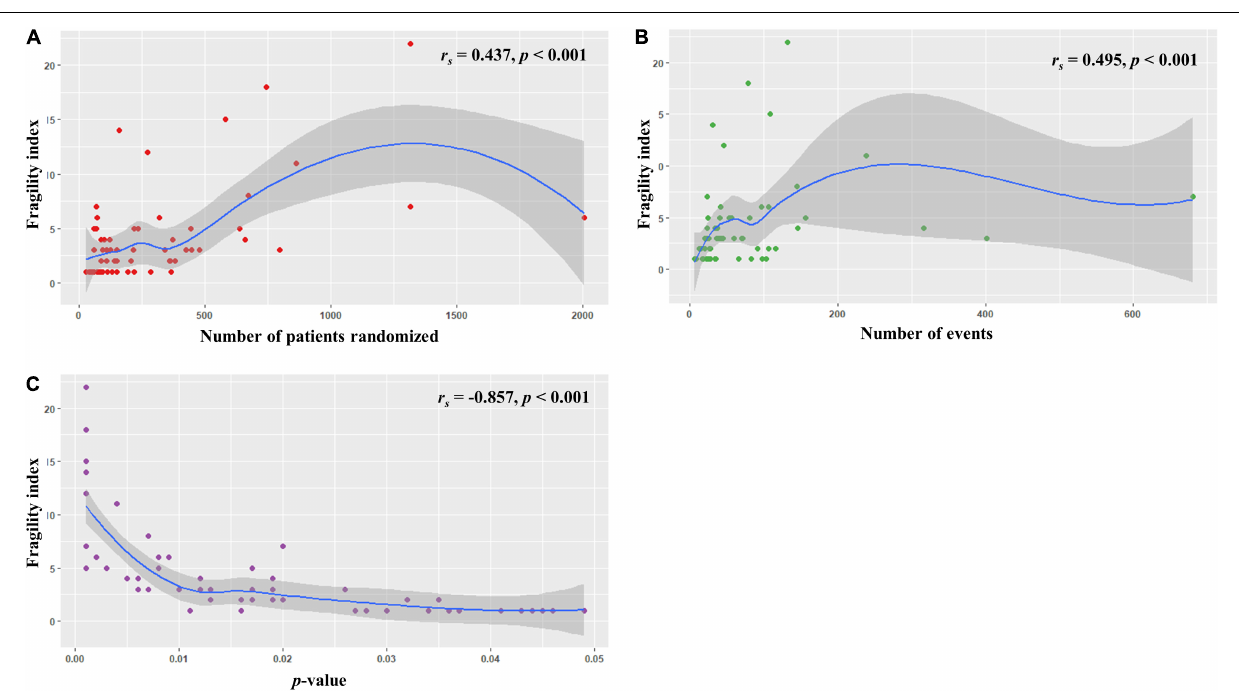
the New England Journal of Medicine (impact factor =